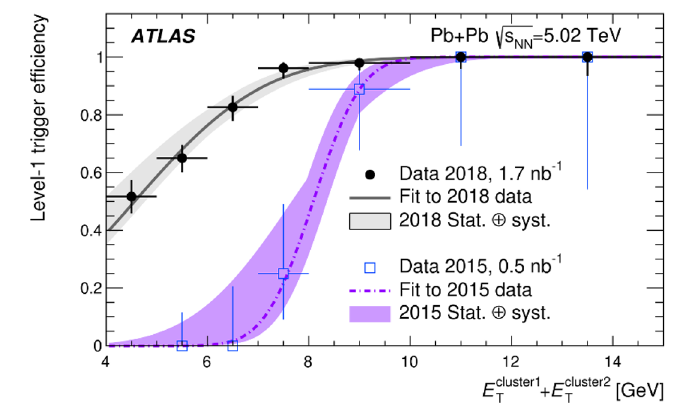
Figure 2 . The Level-1 trigger efficiency extracted from γγ → e + e − events that pass the supporting triggers as a function of the sum of E T of the two EM clusters. Data are shown as points with error bars representing statistical uncertainties, separately for two data-taking periods: 2015 (open squares) and 2018 (full circles). The efficiency is parameterised using the error function fit, shown as a dashed (2015) or solid (2018) line. Shaded bands denote total (statistical and systematic)